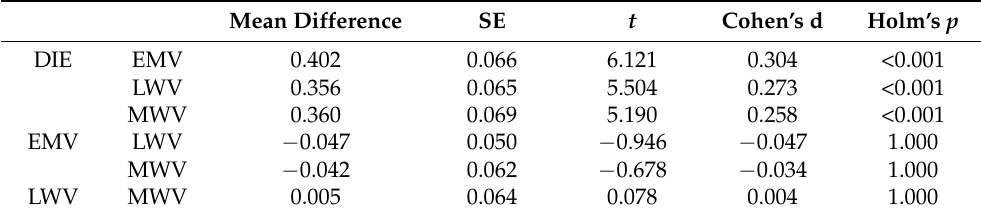
Table 4. Post-hoc Comparisons—Alternative names for microwaves (PRE—addition of preservatives; IRR—irradiation preservation; RWV—radio wave preservation; MAP—packaging in modified at- mosphere preservation; STE—sterilisation; PAS—pasteurisation; HPP—high-pressure processing; MWV—microwave preservation). Mean Difference SE t Cohen’s d Holm’s p DIE EMV 0.402 0.066 6.121 0.304 <0.001 LWV 0.356 0.065 5.504 0.273 <0.001 MWV 0.360 0.069 5.190 0.258 <0.001 EMV LWV − 0.047 0.050 − 0.946 − 0.047 1.000 MWV − 0.042 0.062 − 0.678 − 0.034 1.000 LWV MWV 0.005 0.064 0.078 0.004